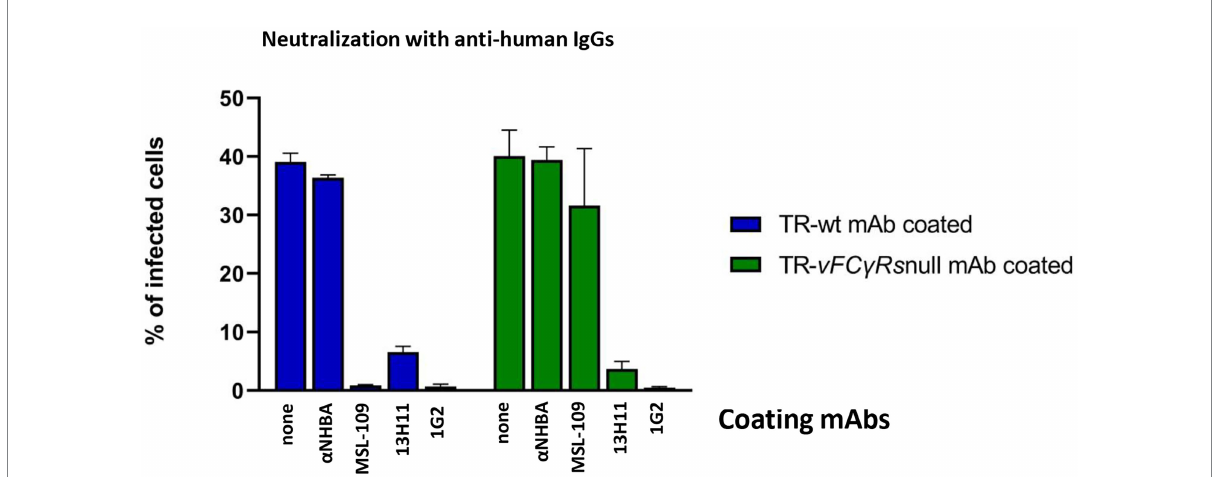
FIGURE 8 Neutralization assay on mAbs-coated viruses with anti-human antibodies. TR-wt and TR- vFc γ Rs null coated with the mAb indicated on each bar and untreated were prepared as described in legend of Figure 7. Viral genomes were quantified by Digital PCR and fresh HFF-1 infected at MOI 1 with viruses pre-incubated with anti-human antibodies. Percentage of infected cells was calculated by cytofluorimetry using an anti-CMV 488-conjugated